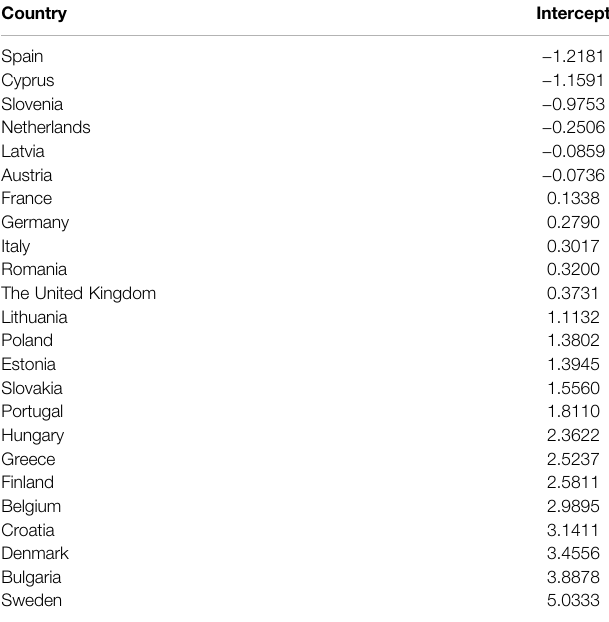
TABLE 6 | Intercept for the countries within the FEM / Source: Own calculation using EViews 11. Country